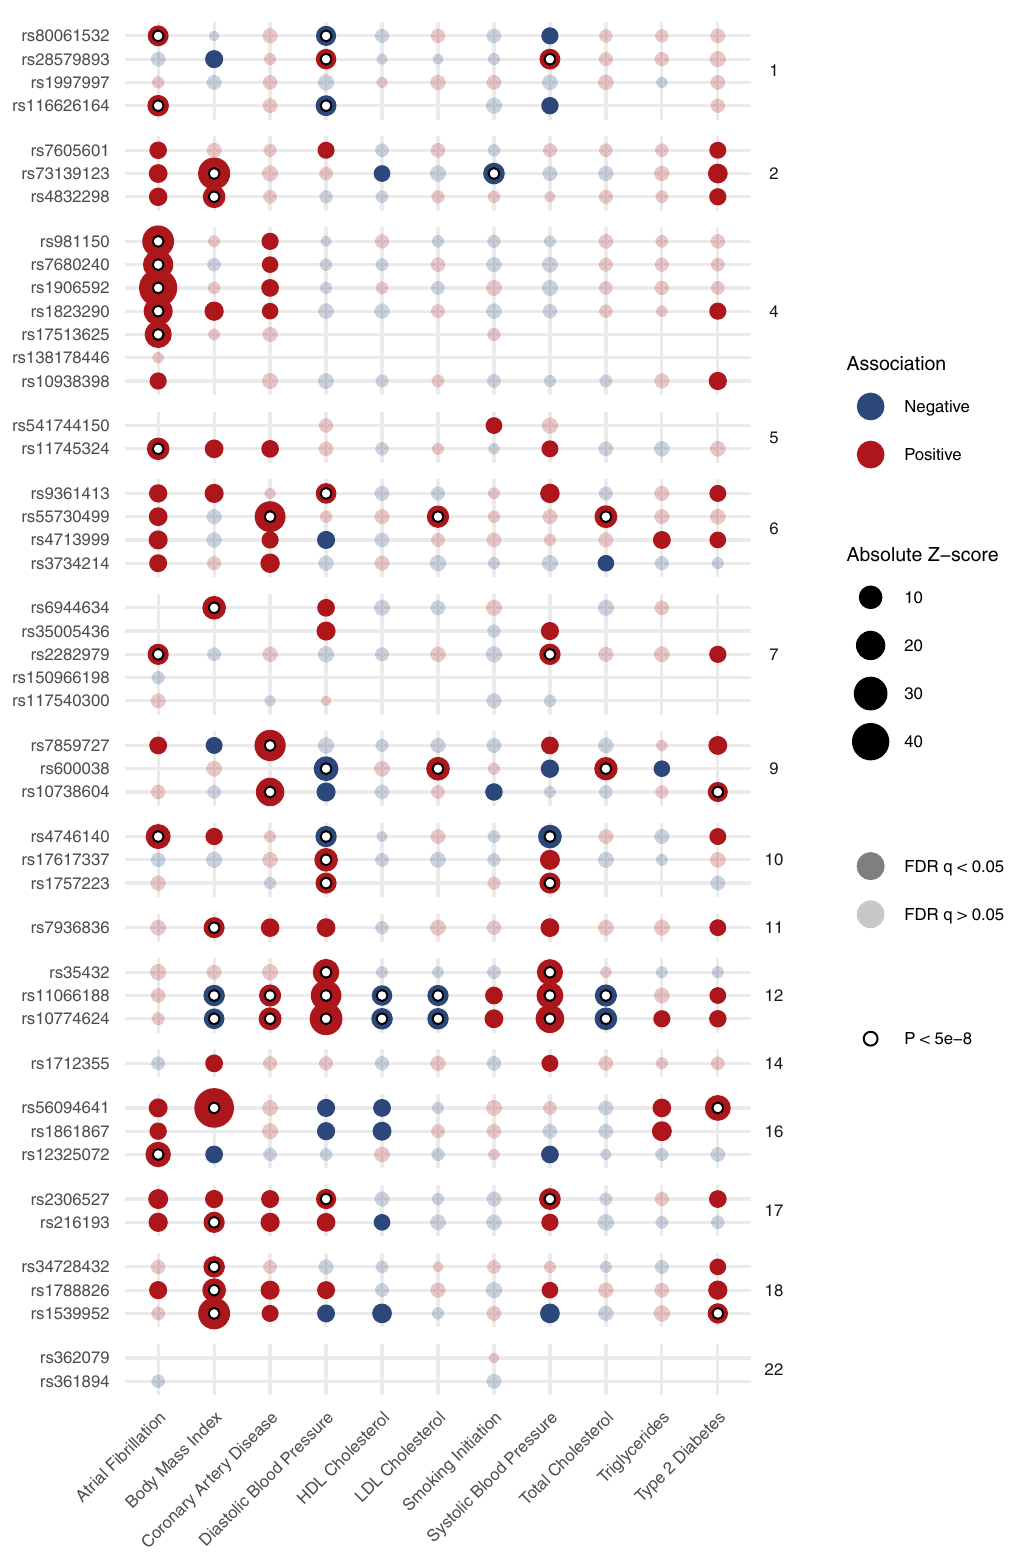
Fig. 3 | Associations of heart failure risk variants with common cardiometa- bolic traits. Dotplot indicating associations between lead variants at heart failure risk loci ( y -axis), with common cardiometabolic traits ( x -axis), with summary esti- mates obtained from GWAS reported inthe IEUOpenGWASProject. Ofthe 47 lead risk variant for HF, 46 (or a proxy) were reported in atleast 1 cardiometabolic trait